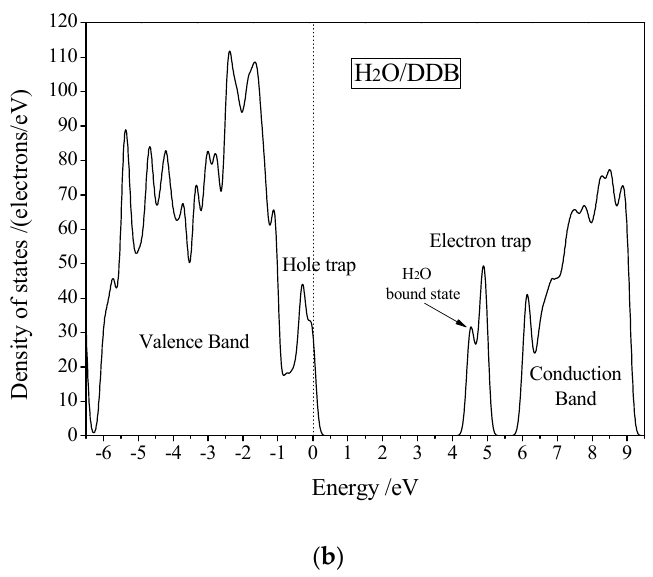
Figure 5. Electronic energy density of ground state for ( a ) pure DDB and ( b ) H 2 O/DDB mixed system (local region at two ‐ phase interface) with the highest occupied state as reference energy zero, Gauss smearing is set as 0.1 eV.